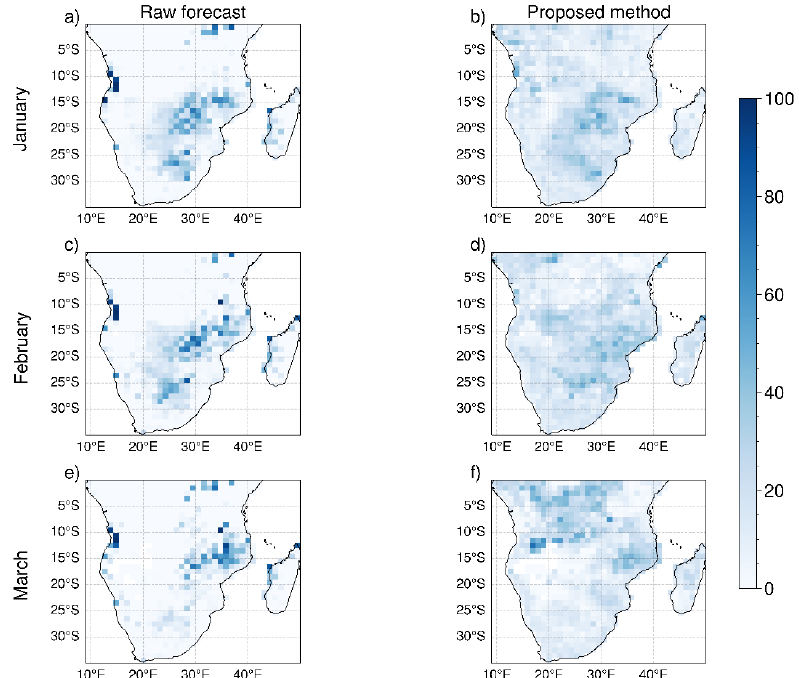
Figure 10. Spatial distribution of average percentage of ensemble members that correctly predict extreme events defined as the values of 2 m mean temperature exceeding the 99th percentile: raw data ( a , c , e ) and bias-corrected data ( b , d , f ). The maps refer to seasonal forecast GCFS2.1 (DWD). Results are shown for the three months (row-wise) and lead time one. In general, the proposed bias correction method improves the percentage of ensem- ble members predicting extreme events. For SEAS5, the percentage increases in the whole study area after the correction. This applies also to System 7 and GCFS2.1 in most of the domain. Some areas present a worsening of the performances after the correction. The percentages for each month and lead time, averaged over the entire domain, are summarised in Figures 11 – 13. As can be seen from the figures, the proposed bias correc- tion method produces a net increase in the percentage of members that are able to cor- rectly predict temperature extremes. The improvement is particularly drastic for SEAS5, whose raw data present a very low percentage (under 1%). Thanks to the correction, we move to a percentage that ranges from 16 to 23%, depending on month and lead time.